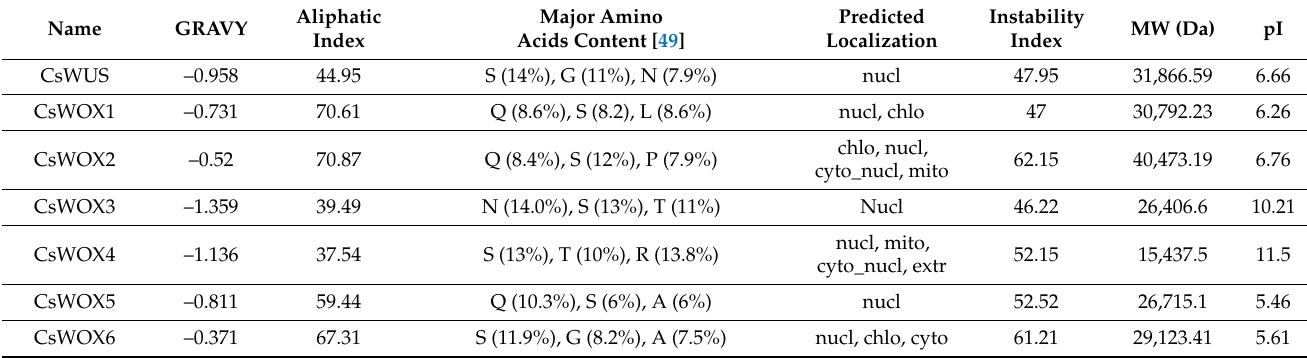
Table 2. Protein composition and physiochemical characteristics of CsWOX